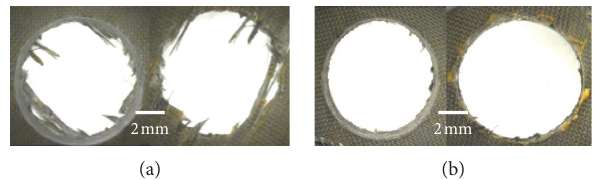
Figure 16: Comparison of two drills. (a) By ordinary drill tip. (b) By complex helicoidal drill.